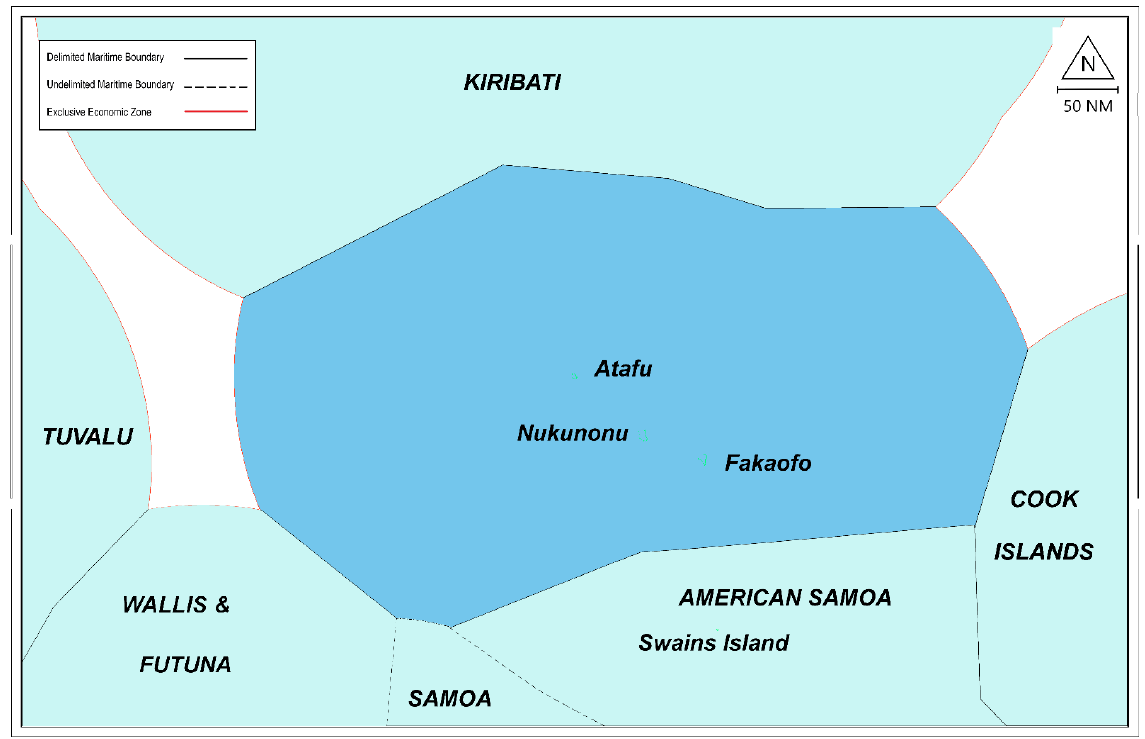
Figure 9. Location of Tokelau’s atolls and islands, including claimed EEZ areas and boundaries.